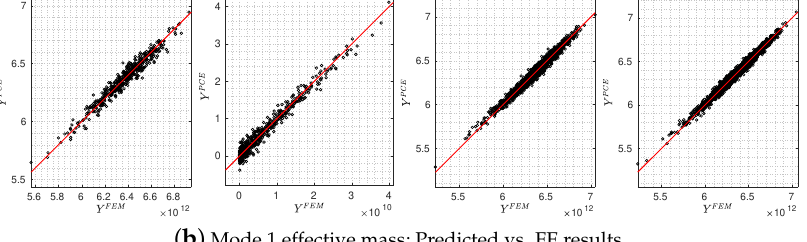
Figure 9. Dam-2; PCE-based surrogate models for varying number of initial DOEs.